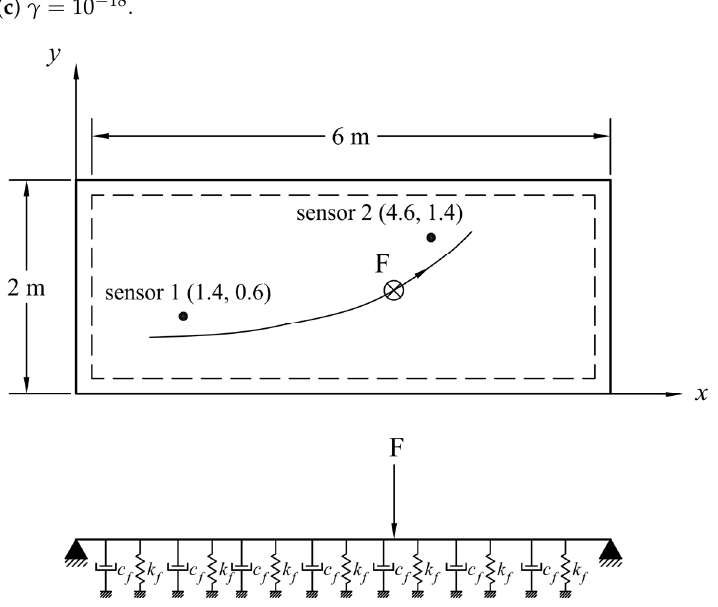
Figure 13. Schematic representation of the problem geometry and boundary conditions, example 2.